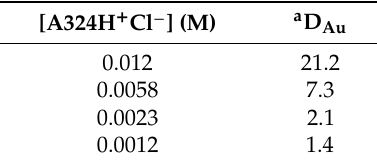
dissolved in Solvesso